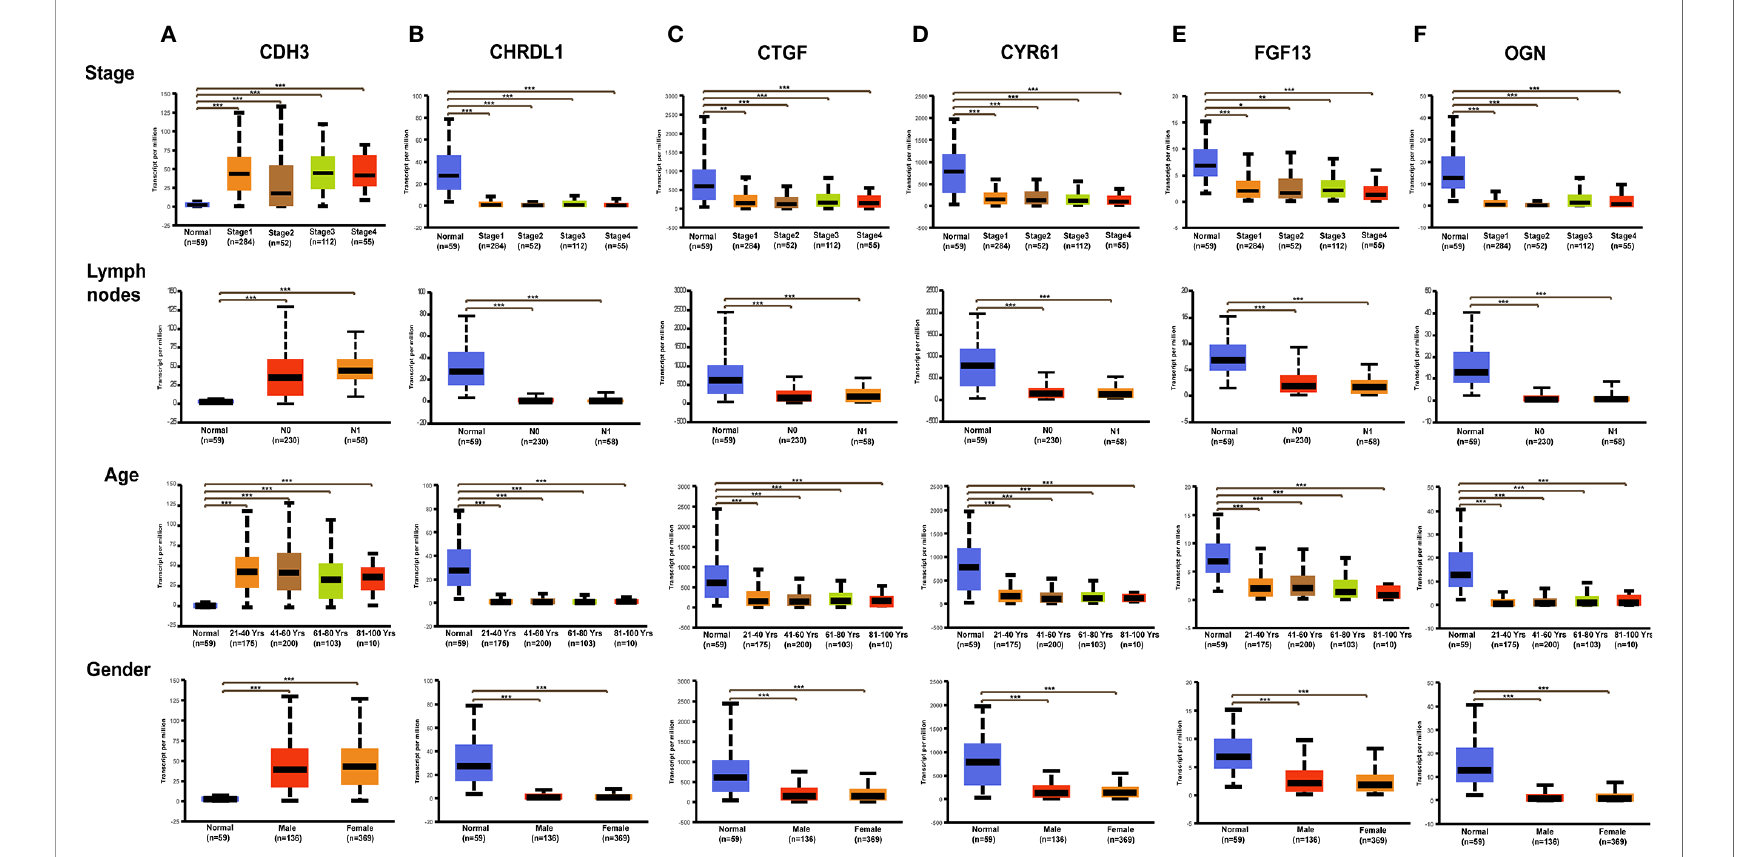
FIGURE 10 | Expression of six hub genes in THCA subgroups strati fi ed by clinical parameters in the UALCAN database. Boxplots showing the relative expression of six hub genes in normal individuals or THCA patients by tumor stage, lymph node metastases, gender, and age, respectively. (A) CDH3 , (B) CTGF , (C) CYR61 , (D) OGN , (E) FGF13 , (F) CHRDL1 . The center lines are the medians, and the bottom and top edges of the boxes are the 25th and 75th percentiles, respectively. *p<0.05; **p<0.01;